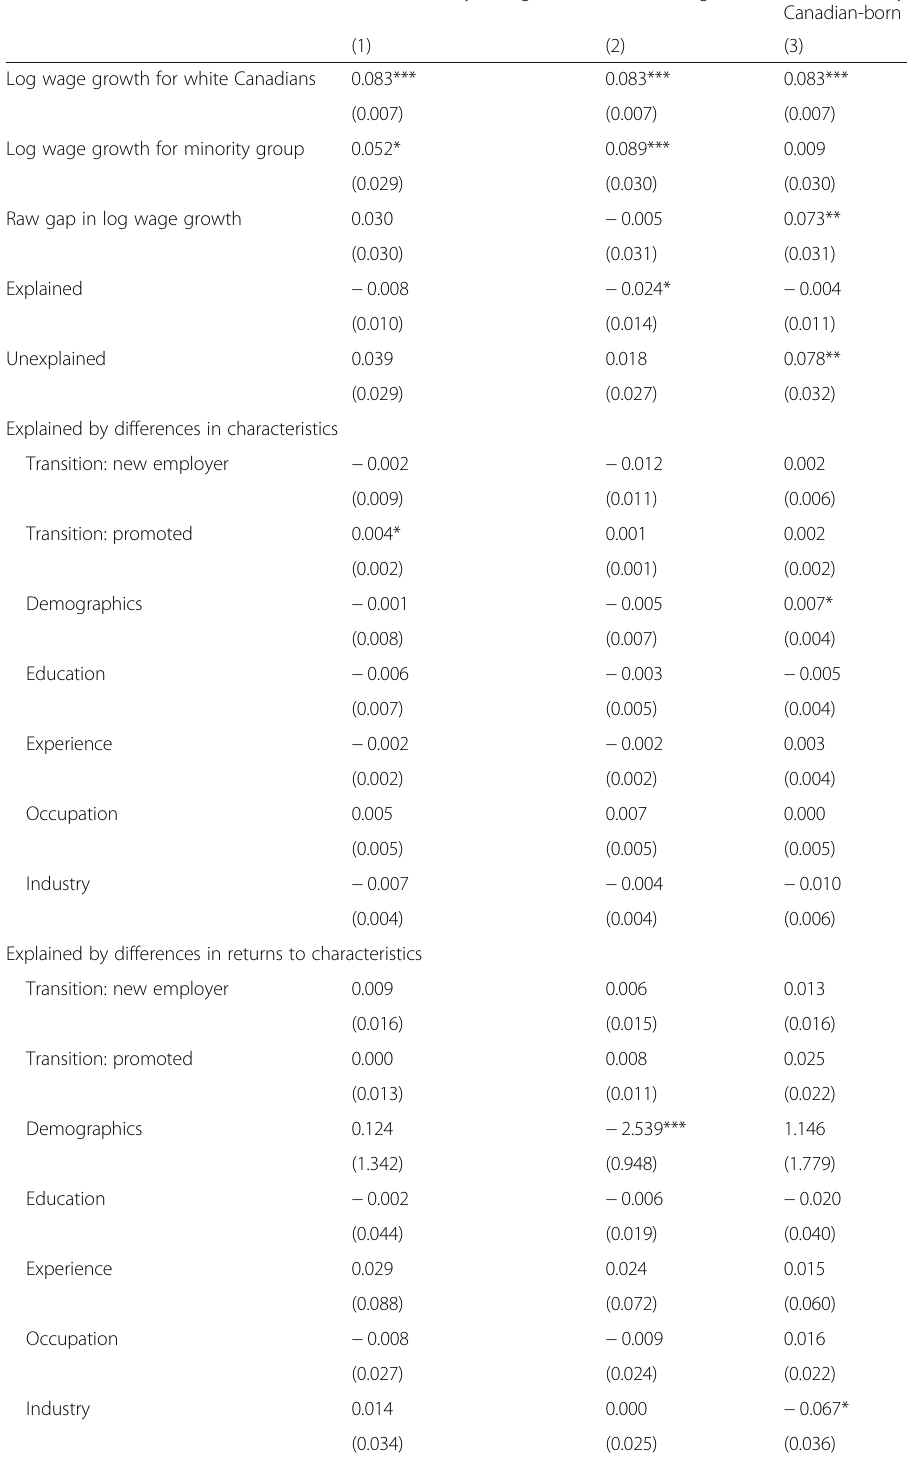
Table 11 Robustness of O-B decompositions Visible minority immigrants White